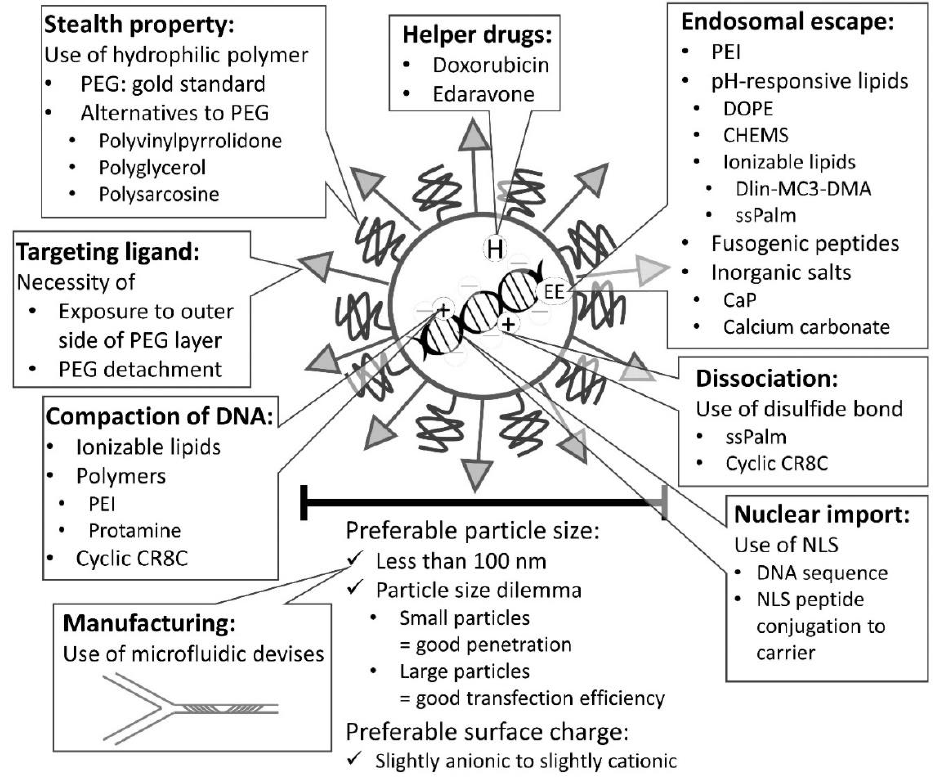
Figure 4. The information for designing ideal non-viral vectors.